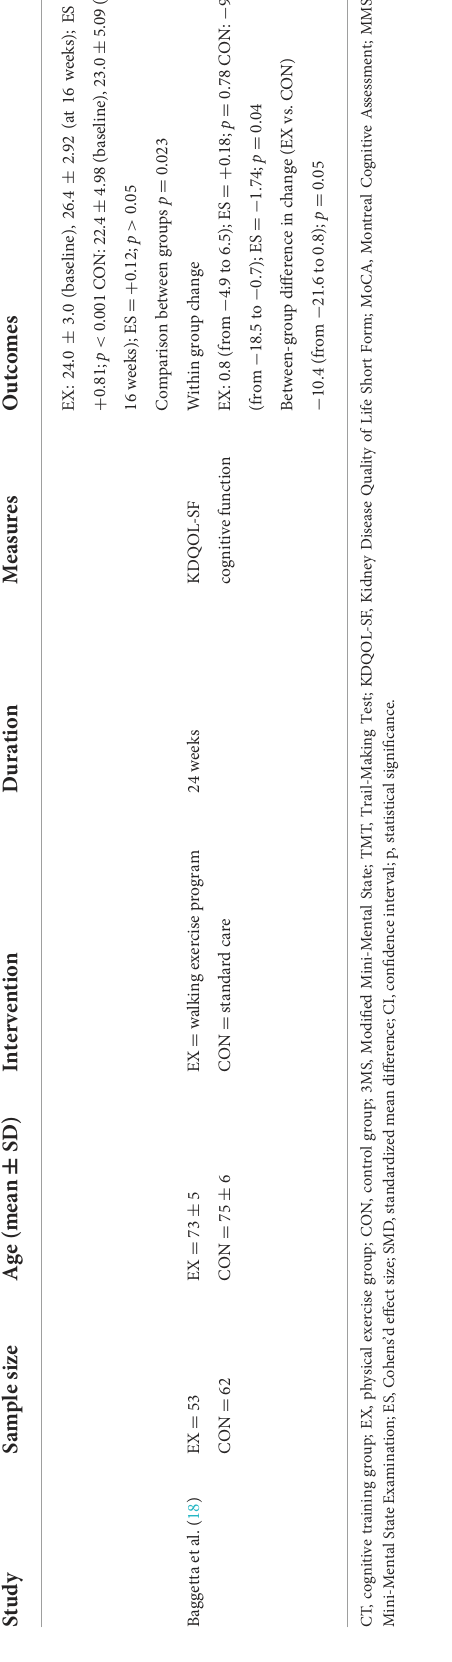
TABLE 4 Description of cognitive